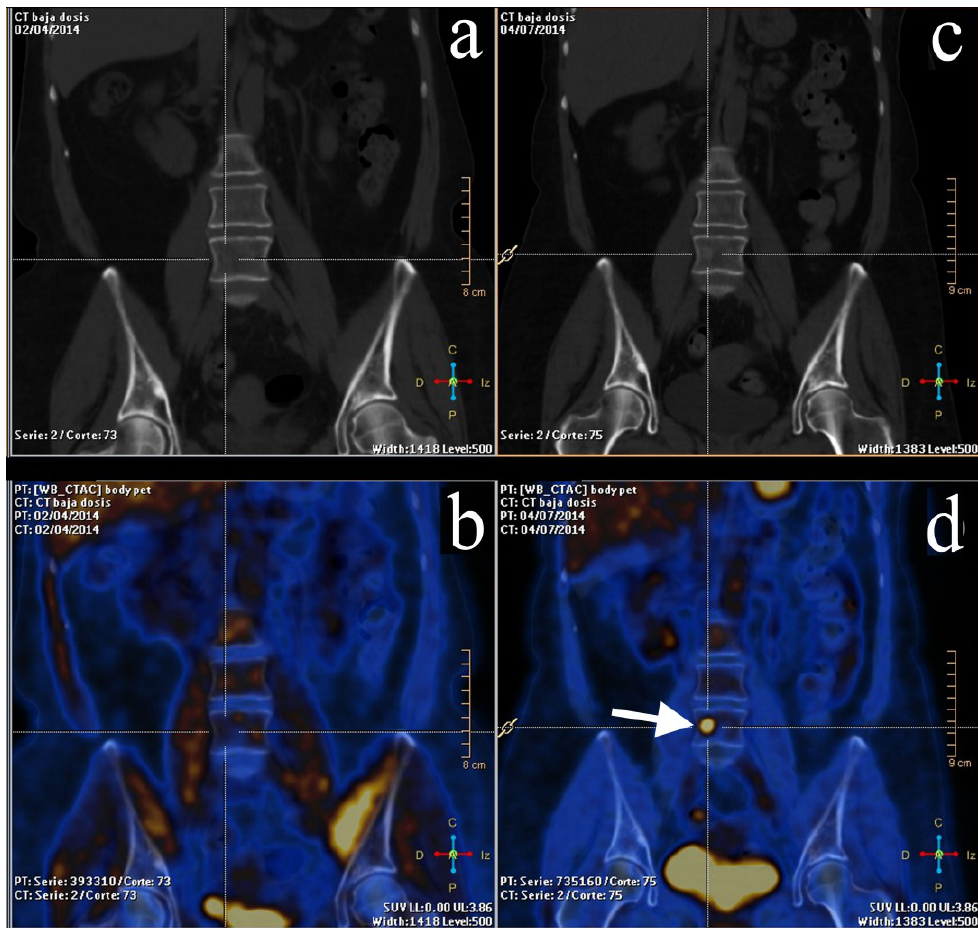
Figure 3. Same patient as Figure 2. Left column : baseline PET/CT scan. ( a , b ) No abnormality was noticed on CT or PET/CT. Right column : mid-therapy PET/CT scan. ( c ) Non-enhanced CT showing an iso-hyperdense rounded lesion in the fourth lumbar vertebrae, called to be as undetermined. ( d ) PET/CT demonstrating a focus of FDG uptake (arrow) in the lumbar vertebrae due to bone